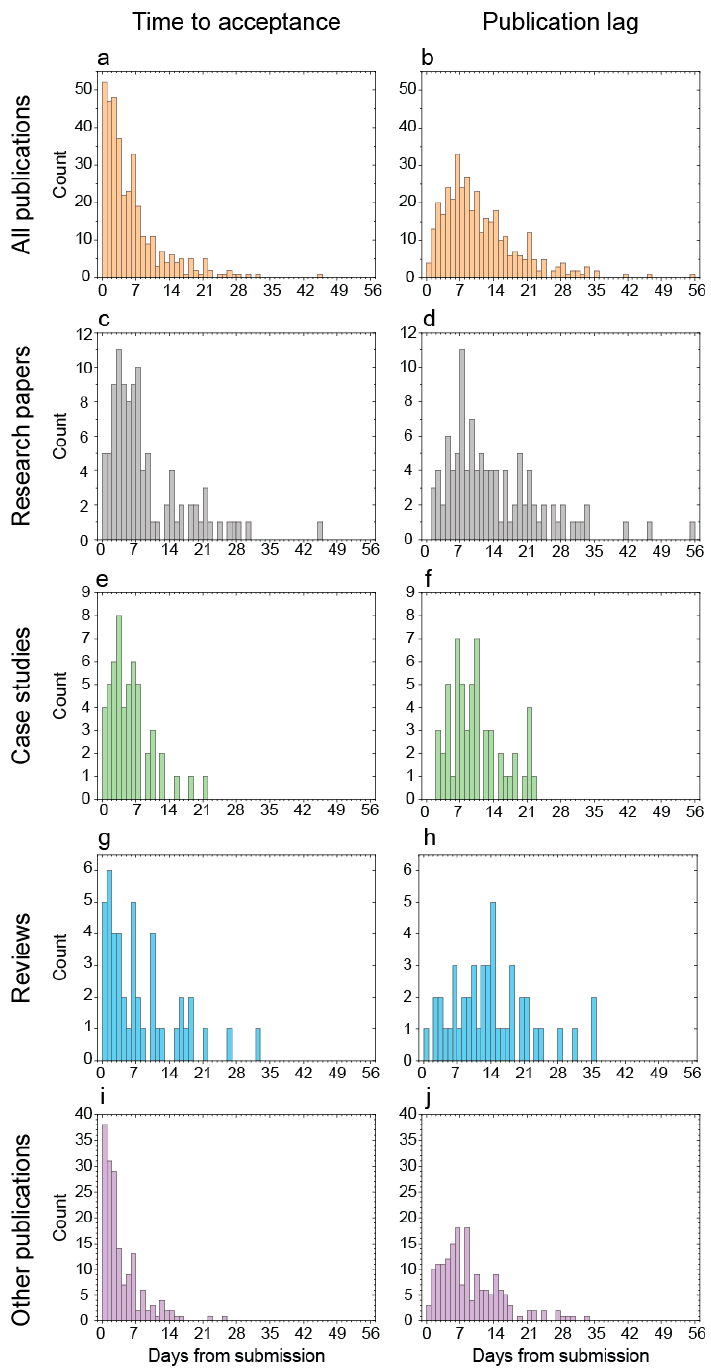
Figure2. Numberofdocumentswithgivennumberofdaysfromsubmissiontoacceptance( a , c , e , g , i )